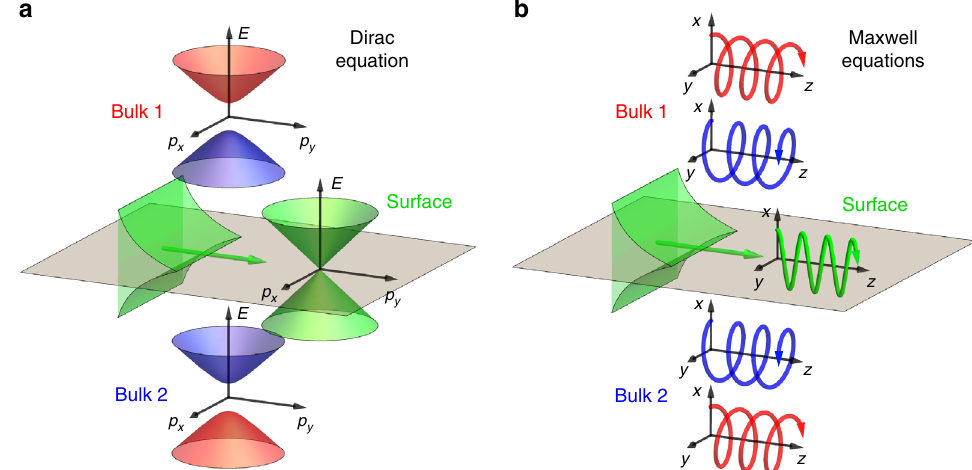
Fig. 1 Schematics of topological surface modes in the Dirac and Maxwell equations. a The Dirac equation with a fi nite mass m is characterized by the gapped bulk spectrum E ( p ). An interface between “ media ” with opposite-sign masses ± m , and bulk spectra (schematically shown in red and blue), supports topological surface modes with massless spectrum (shown in green) 1 – 3,27 . b Maxwell equations possess massless bulk spectra (not shown here), which are double-degenerate with respect to opposite helicity states. These bulk helicity eigenmodes have opposite circular polarizations, i.e., chiral spatial distributions of the electric or magnetic fi eld (shown in red and blue here). An interface between two media with different helicity properties (controlled by the signs of the permittivity ε and permeability μ of the medium) supports zero-helicity surface waves with transverse-electric or transverse-magnetic linear polarizations (shown in green) 15 – 19